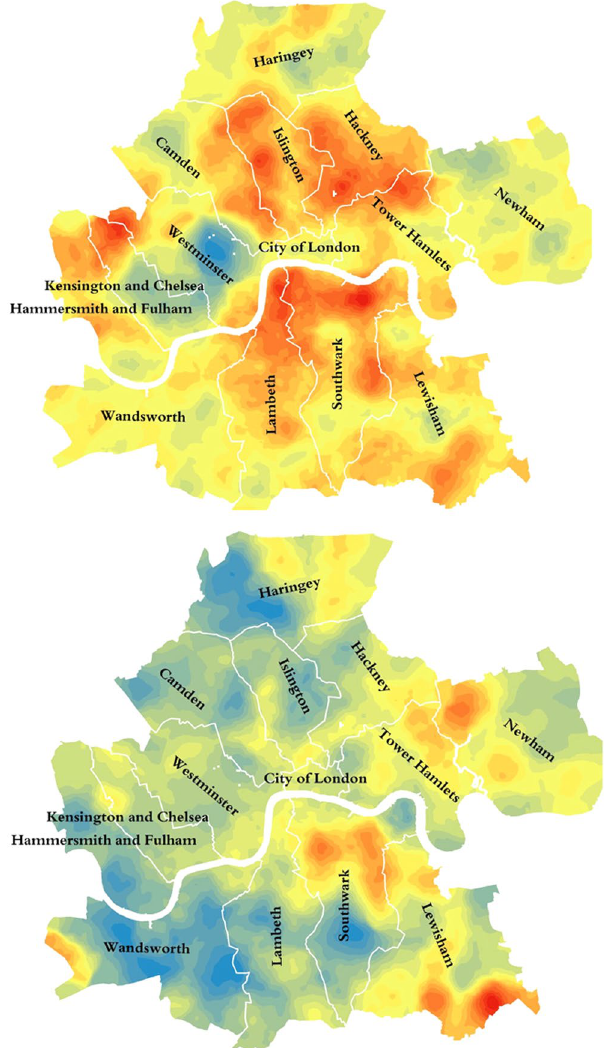
Figure 2. Medically- (top) and self- (bottom) diagnosed populations in Central London. Maps produced with the Experian Mosaic Public Sector data, using ArcGIS Desktop v.10: ESRI 2011. Redlands, CA: